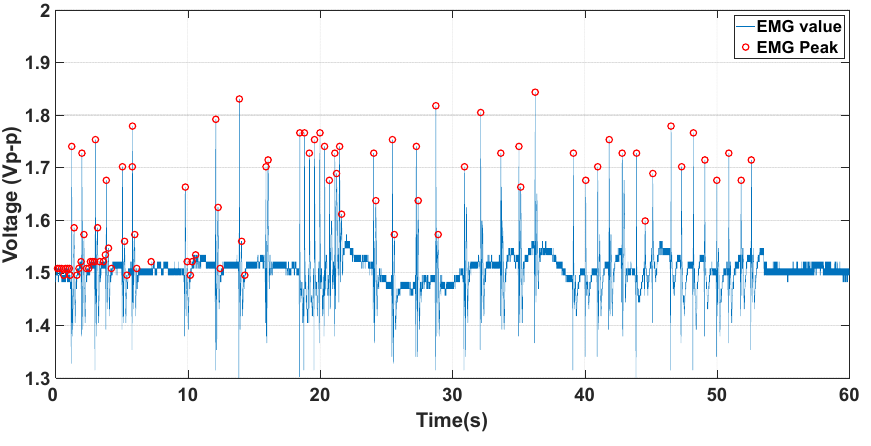
Figure 8. Peak detection of the S & C algorithm.